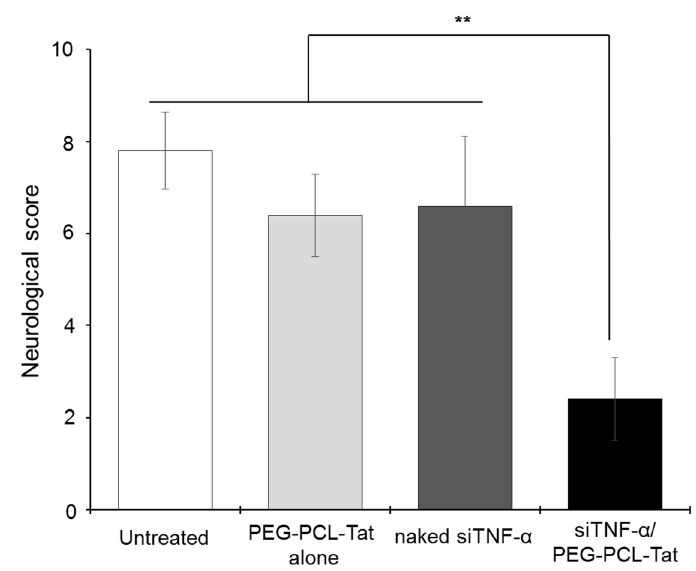
Figure 5. The neurological score of MCAO rats treated with intranasal administration of siTNF- α / PEG-PCL-Tat complex. The neurological score was evaluated based on spontaneous activity, drifting during displacement, parachute reflex, and resistance to right forepaw stretching. Each bar represents the mean ± S.E. ( n = 5). ** p < 0.01.